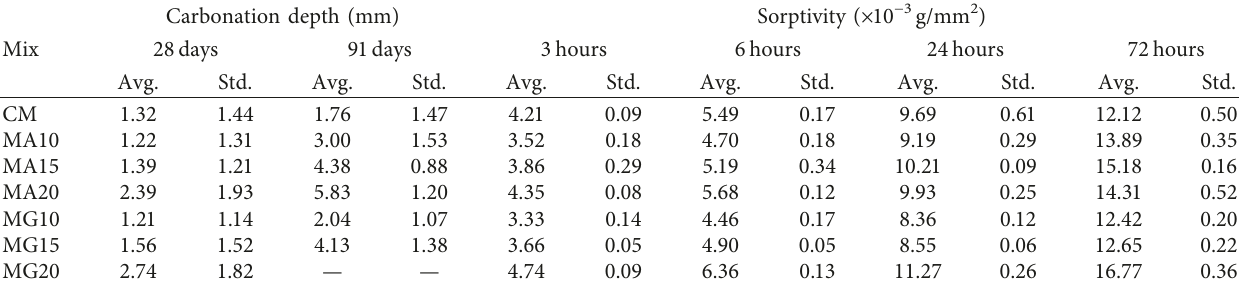
Table 4: Carbonation depth and sorptivity of specimens with increasing MgO content.